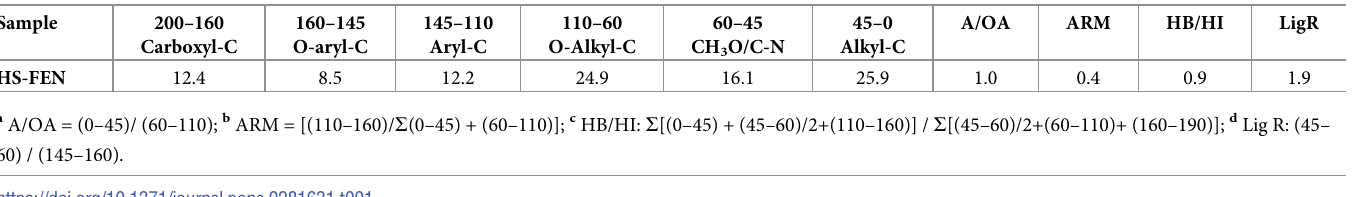
dimensionless structural parameters calculated from the relative amounts of carbon distribu- tion over intervals of the spectral range (Table 1). The value of hydrophobic index close to unity, indicates a uniform partition of C between polar and apolar functional groups mainly determined by the aliphatic components as suggested by the similar result found for the alkyl ratio (Table 1). However, the ARM index suggests a significative content of aromatic mole- cules, while the low level of LigR shows a close correlation of spectral intensities associated to methoxyl groups (45–60 ppm) and O-aryl-C molecules (140–160 ppm), thus revealing the prevalent contribution of lignin fragments and phenolic compounds in these spectral regions (Table 1).